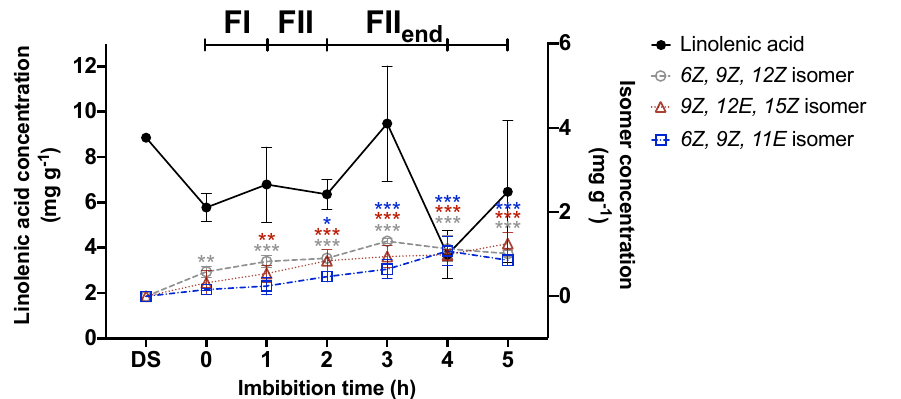
Figure 6. Fatty acid isomers in S. hispanica seeds. The imbibition stages (FI, FII and FII end ) are indicated throughout the imbibition trend at 30 ◦ C. Concentrations were calculated relative to the weight of non-imbibed seeds (NI) within the total weight. Values are expressed as mean ± SD of three independent replicates. Asterisks correspond to data with statistical differences regard with control concentration in NI (* p = 0.033; ** p = 0.002; *** p < 0.001); the colors of the asterisks indicate significant differences to the corresponding isomer with the same symbol color. Left y-axis corresponds to the concentration of Ln; while the right y-axis corresponds to the isomers’